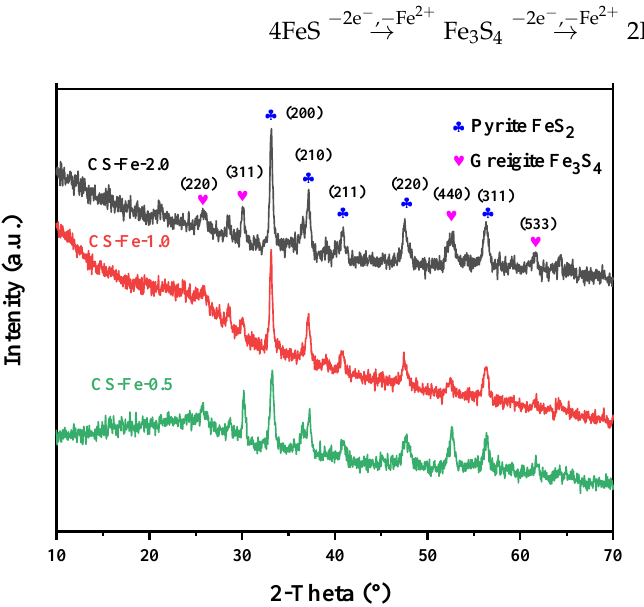
Figure 1. XRD spectra of the prepared samples.